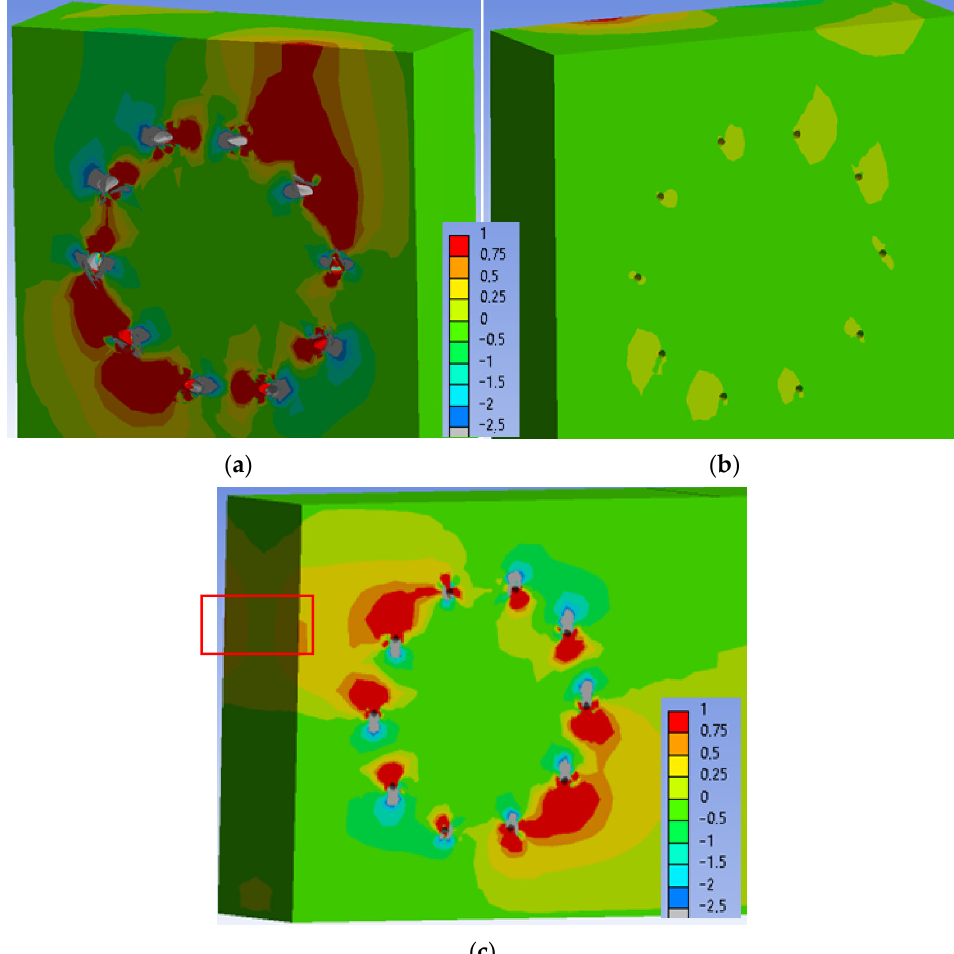
Figure 29. Tensile stress perpendicular to the grain [MPa] at 100% ULS, Experiment B: ( a ) inner side of the stand; ( b ) outer side of the stand; ( c ) rung.